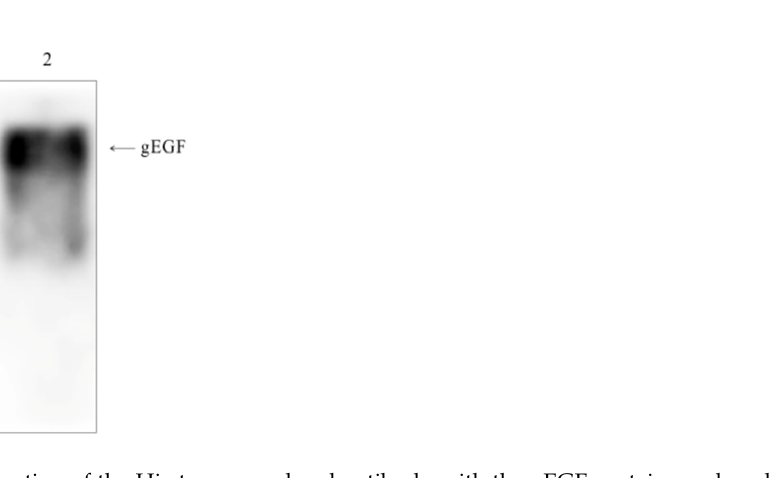
Figure 1. Hybridization of the His-tag monoclonal antibody with the gEGF protein produced by the Lactococcus lactis recombinant strain. Lanes 1 and 2: 20 µ L/well of the supernatants from the LL-pNZ8149 and the LL-pNZ8149-gEGF fermentation products, respectively. The recombinant gEGF is marked by an arrowhead.